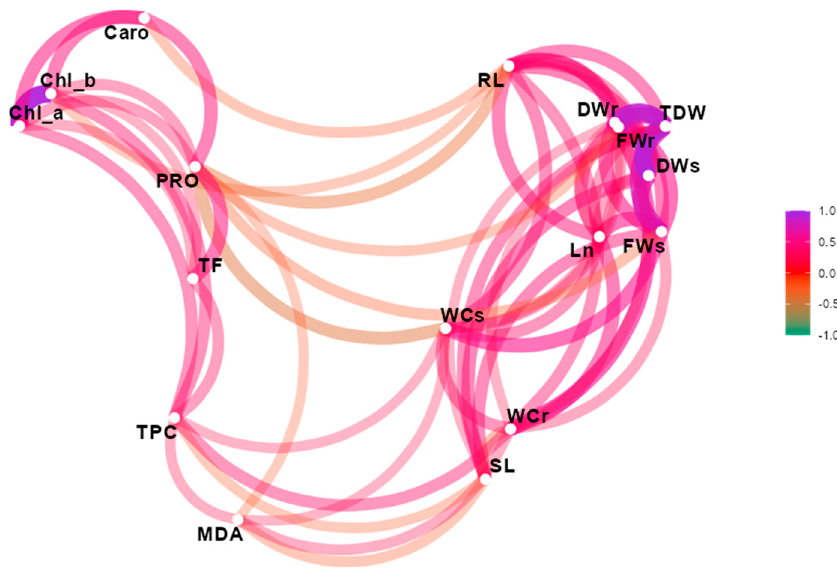
Figure 12. Correlation network diagram displaying significant correlations ( p < 0.05) between the 17 measured traits under control, intermediate, and severe water-stress conditions for the six species under analysis. Each node depicts a variable, and highly correlated variables are clustered together. Each path represents a correlation between the two traits it joins. A violet path indicates a positive correlation, and a green path indicates a negative correlation. Only significant correlations are illustrated. The width and transparency of the stripes express the strength of the correlation (wider and less transparent = stronger correlation). Abbreviations: shoot fresh weight (FWs), shoot dry weight (DWs), root fresh weight (FWr), root dry weight (DWr), total dry weight (TDW), shoot water content (WCs), root water content (WCr), shoot length (SL), root length (RL), leaf number (Ln), chlorophyll a (Chl a), chlorophyll b (Chl b), carotenoids (Caro), proline (PRO), total flavonoids (TF), total phenolic compounds (TPC), malondialdehyde (MDA).